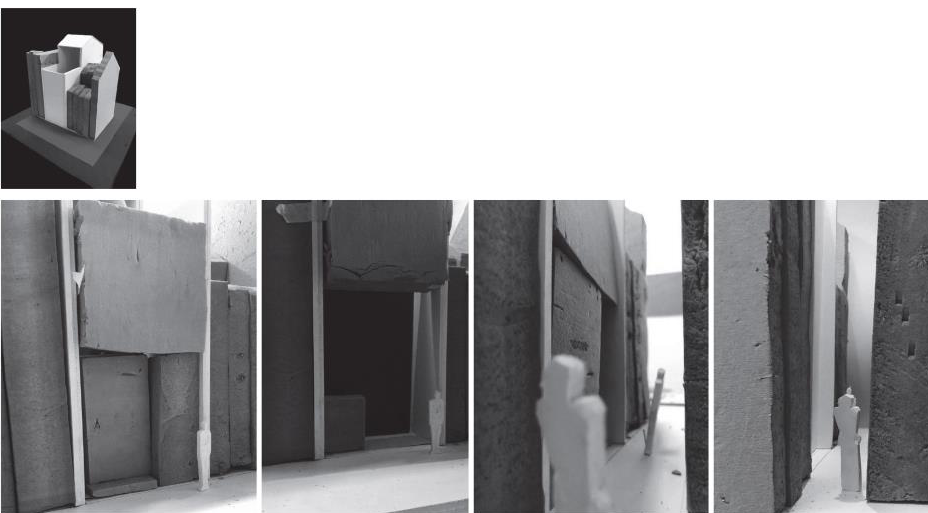
Figure 18. Testing the relationship between the building and the street via volume modeling (modeled by the students).